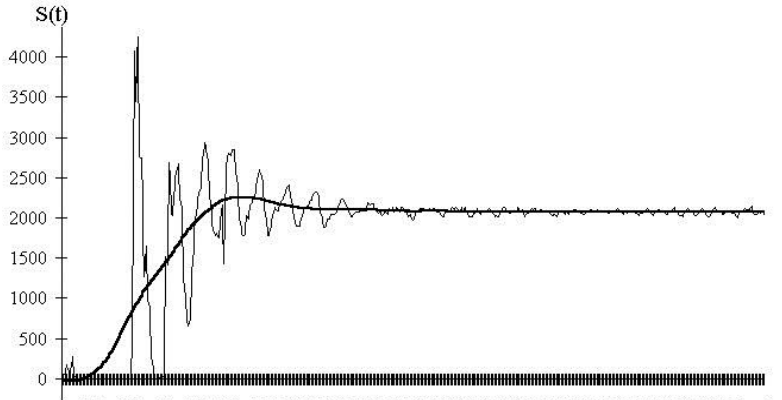
Fig. 10. Transient measurement processing